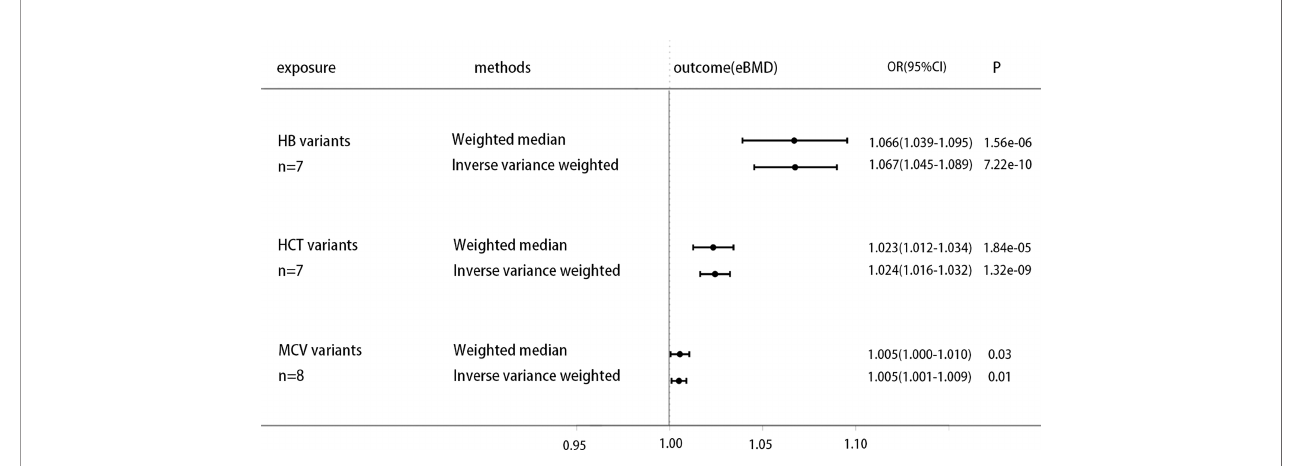
FIGURE 3 | Causal effect on eBMD in UKBB of increased erythrocytic traits, including genetic variants of Hb, HCT and MCV. MR analysis were performed by the IVW and WM methods. Effect estimates are OR of eBMD per %-unit increase in erythrocytic traits.